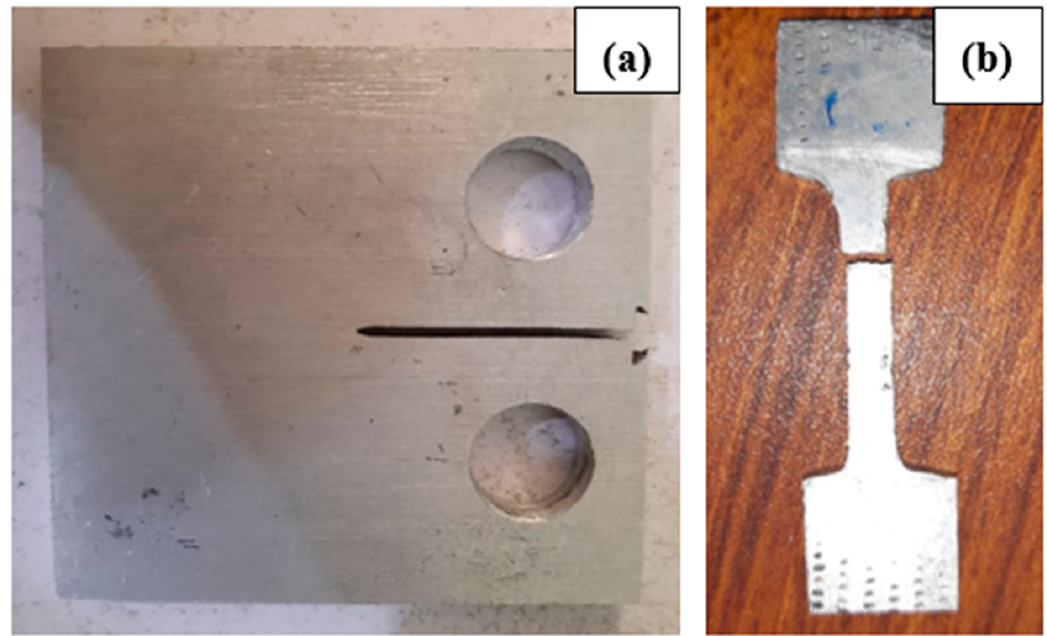
Figure 1. ( a ) Sample after cutting, machining, drilling, and notch making. ( b ) Fracture sample after tensile test.